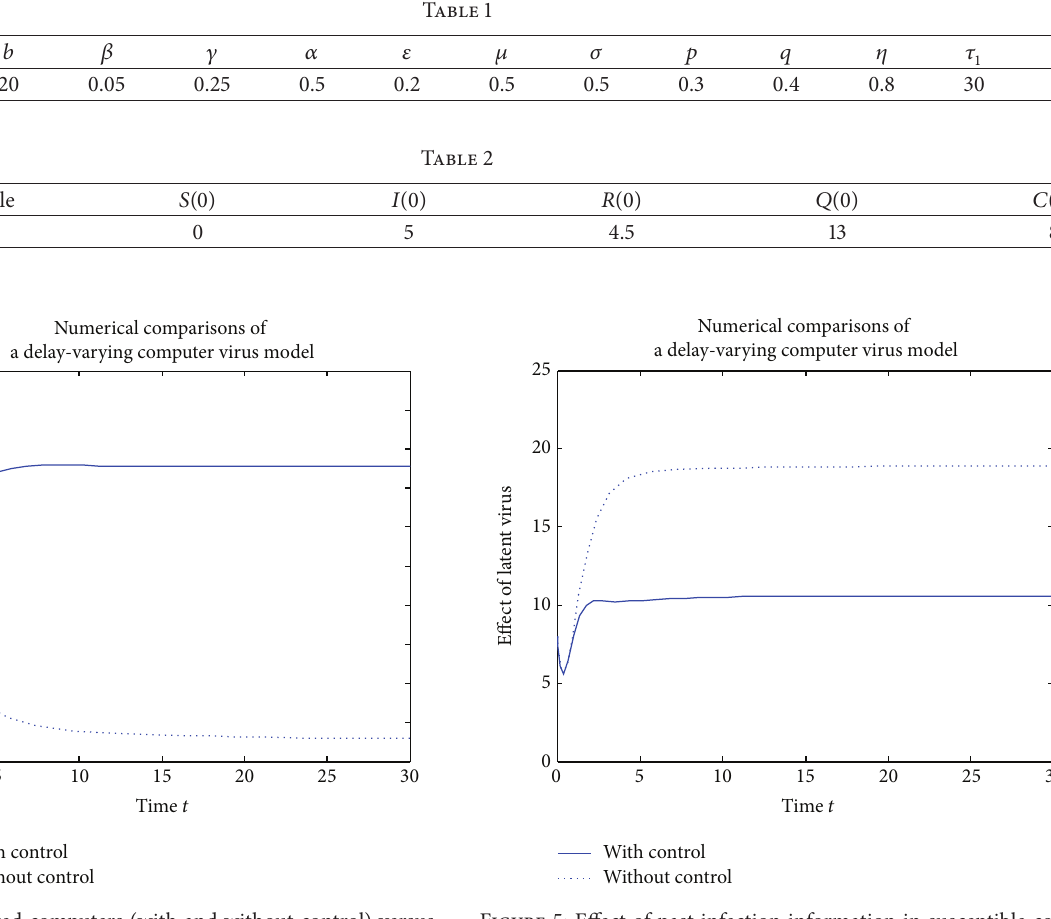
Figure 5: Effect of past infection information in susceptible com- puters (with and without control) versus time 𝑡 .